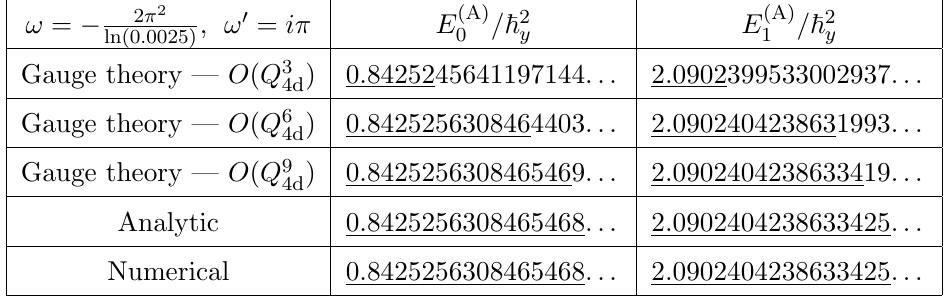
~ y . The spectrum is the same as the one in 2